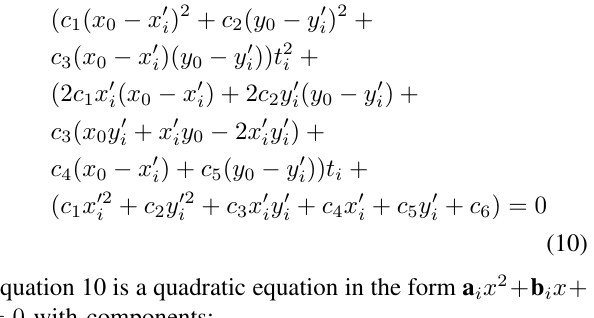
p 0 ' contour edge